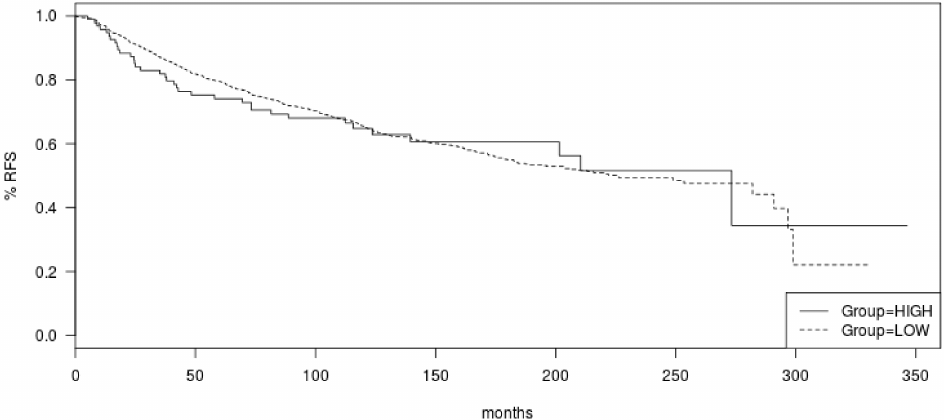
Figure 6. Relapse-free survival (RFS) of ER-positive/HER2-negative breast cancers according to total mutation count in the METABRIC cohort. Log Rank p = 0.9.